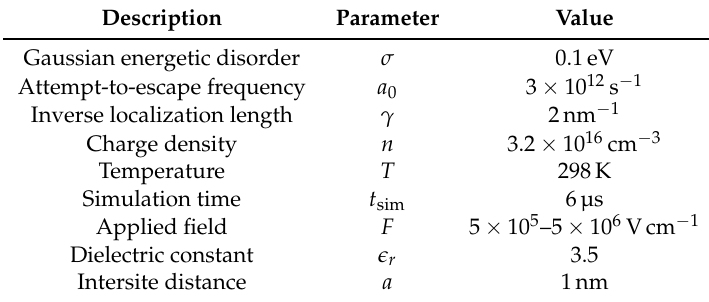
Table 1. Simulation parameters for mobility considering polymer chains.